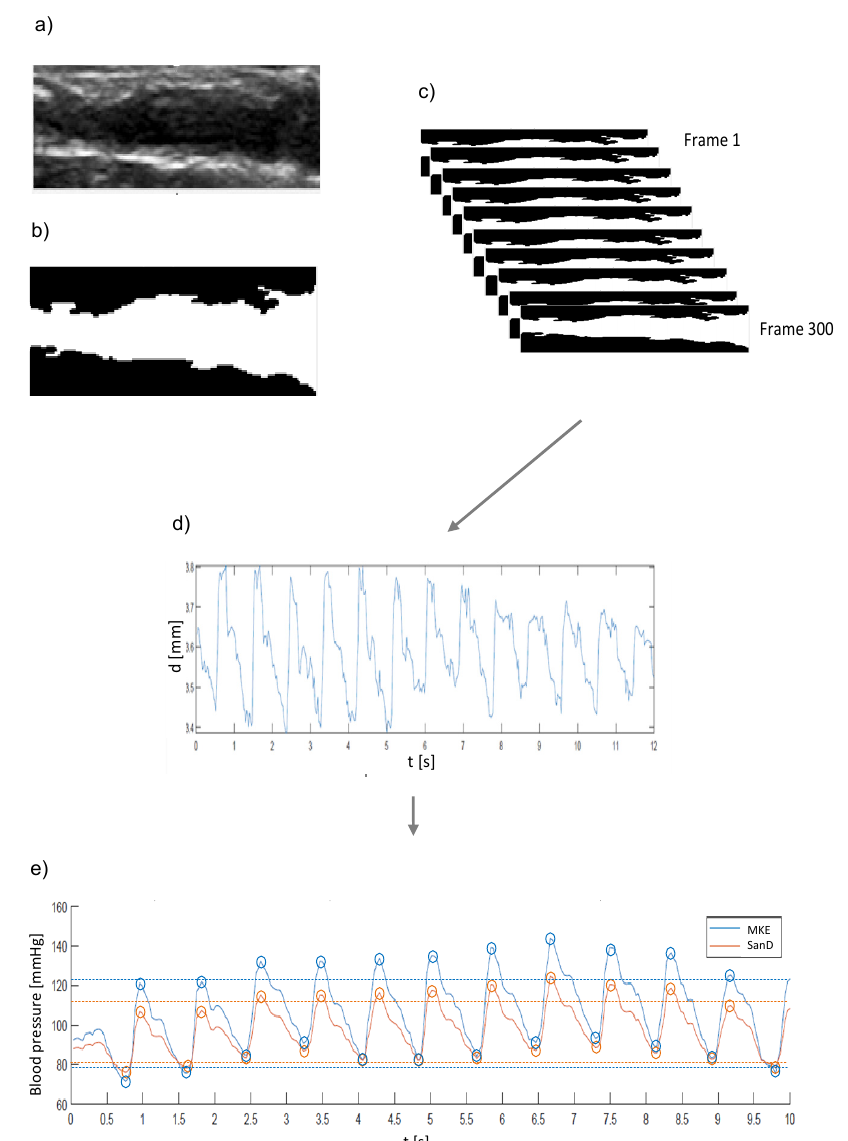
Figure 2. Processing flowchart of the sequential video analysis: ( a ) extraction from the video; ( b ) separation of tissue (black) and vessel area (white); ( c ) calculation of the vessel diameter of approximately 300 frames; ( d ) display as a curve; ( e ) transfer via the algorithm to blood pressure curves over time in seconds.